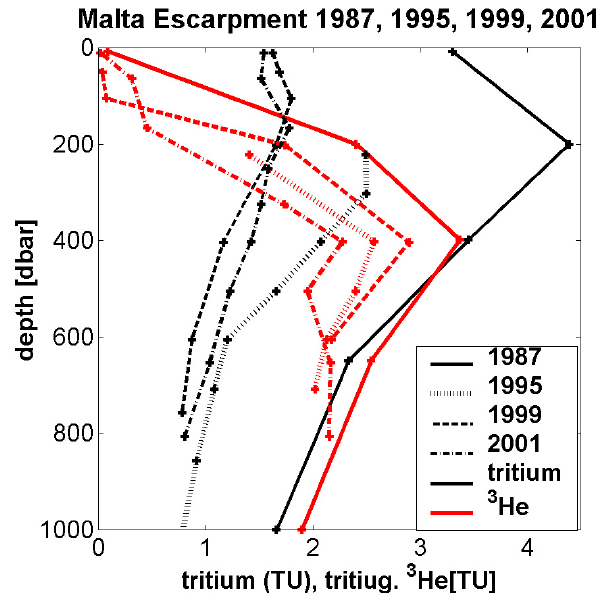
Fig. 7. Profiles of tritium and tritiugenic 3 He off the Malta Es- carpment in 1987 (M ETEOR 5/6, Sta. 779), 1995 (M ETEOR 31/1, Sta. 8), 1999 (M ETEOR 44/4, Sta. 303) and 2001 (M ETEOR 51/2, Sta. 558). For station positions see Fig. 1. The locations of the 1999 and 2001 stations are somewhat farther away from the escarpment. Note temporal inversions in the general trend of decreasing tracer